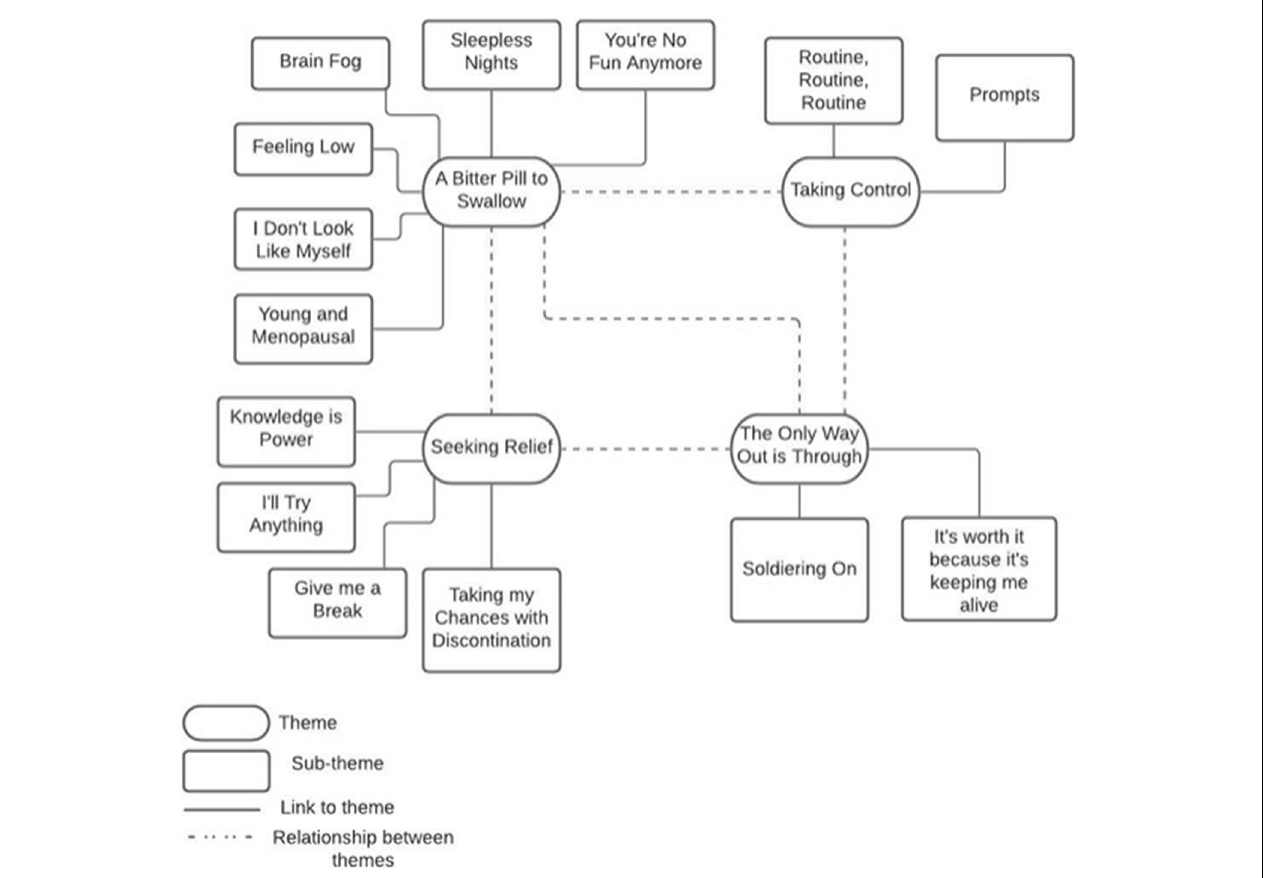
FIGURE 1 | Thematic map demonstrating four main themes and corresponding